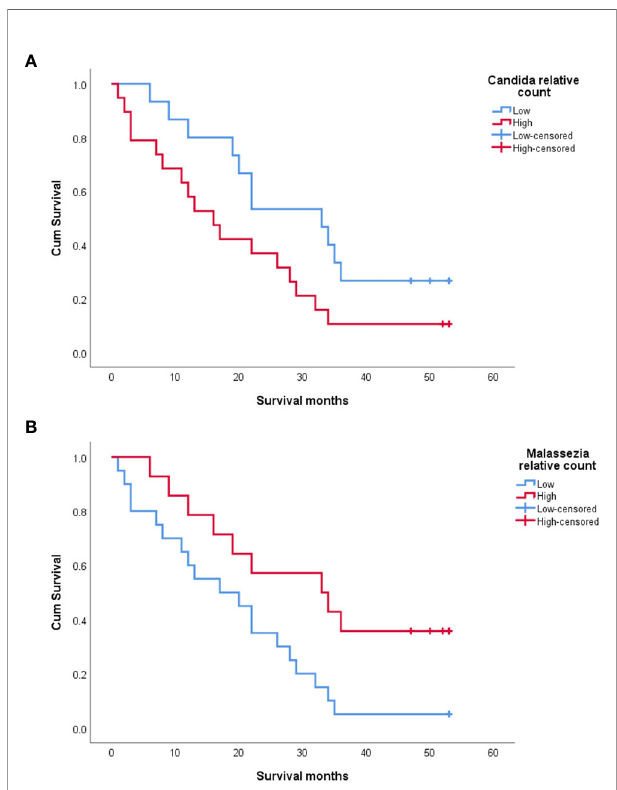
FIGURE 5 | Kaplan – Meier survival curves showing the impact of salivary Candida (A) and Malassezia (B) on the overall survival of oral squamous cell carcinoma (OSCC)